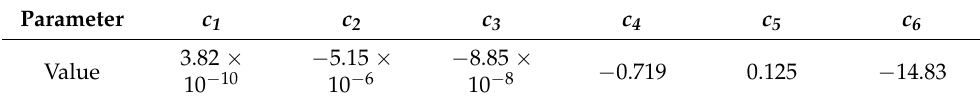
Table 2. Values of the parameters of Equation (8), calculated from the training data set.